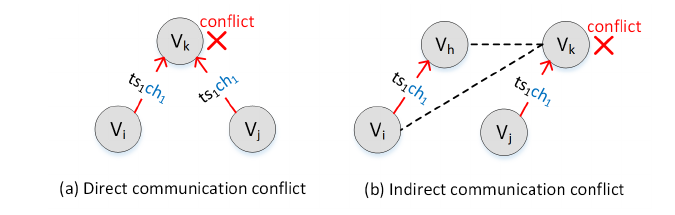
Figure 1. Example of many-to-many data aggregation scheduling in WSN.